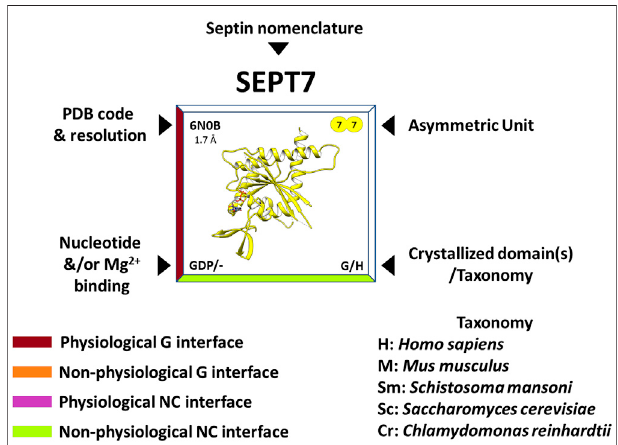
FIGURE 2 | Features of the “ Septin Chart ” (see complete fi gure in Supplementary Figure S1 ). The PDB code and resolution are shown in the upper left corner, the contents of the asymmetric unit in the upper right, the presence and nature of the bound nucleotide/magnesium in the lower left corner and fi nally, in the lower right, the puri fi ed and crystallized domain(s) as well as the acronym of the organism to which it belongs (e.g., H (cid:1) Homo sapiens ).Inaddition, theedgesoftheboxsurroundingthestructurearecolor- codedandrefertothecontactinterfacesobservedinthecrystal:burgundyfor a physiological G-interface, orange for a non-physiological G-interface, purple for a physiologicalNC-interface and lime for a non-physiological NC-interface. In some cases, in order to observe some of the interfaces, it is necessary to apply crystallographic symmetry operations to the asymmetric unit.